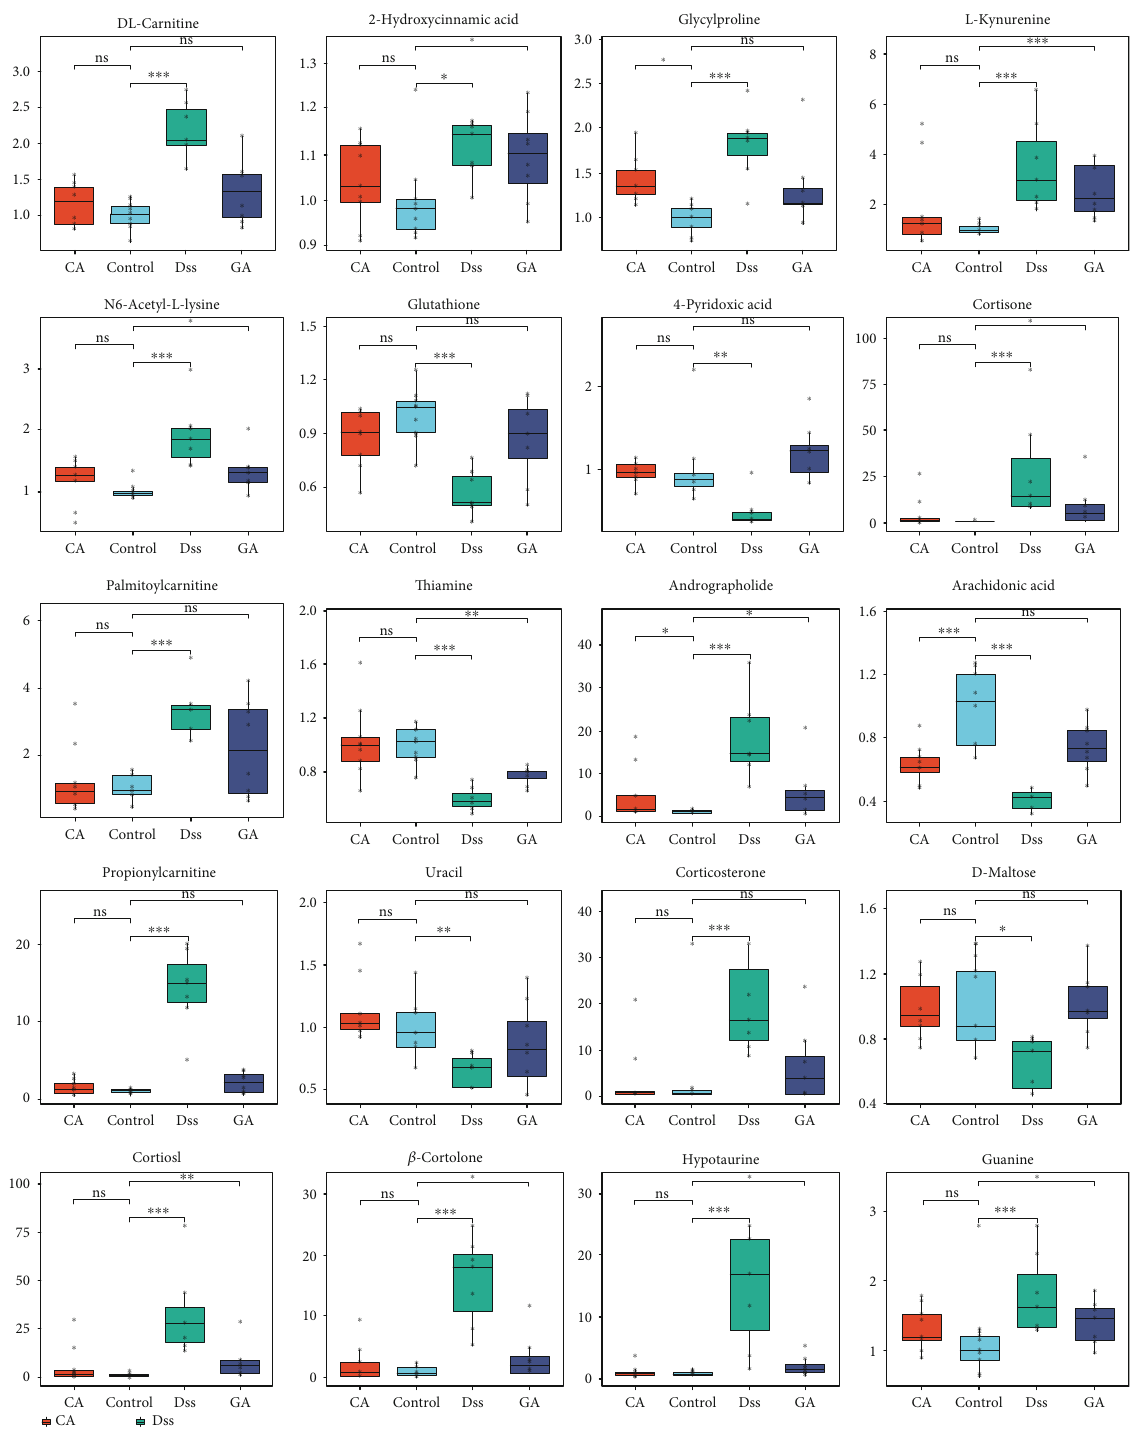
Figure 4: Box-plot of potential metabolites in the four groups: control, DSS, CA and GA group ( ∗ P < 0 : 05 , ∗∗ P < 0 : 01 , ∗∗∗ P < 0 : 001 , ns means not signi fi